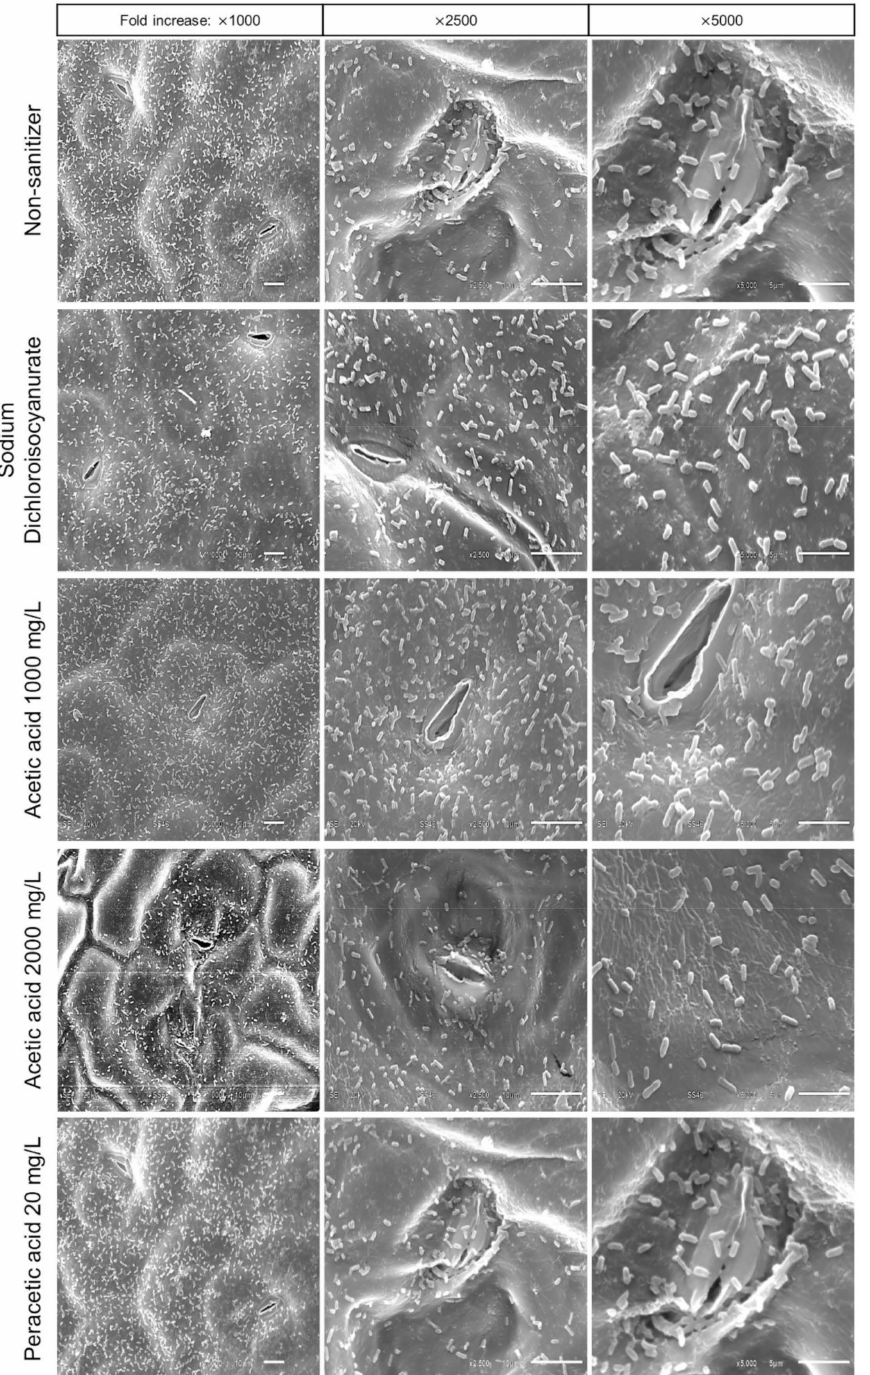
Figure 3. Scanning electronic microscopy micrographs of kale samples intentionally contaminated with S. Typhimurium cells ATCC 14028 and submitted to different sanitization treatments (Non sanitizer, sodium dichloroisocyanurate; Acetic Acid 1000 mg/L; Acetic Acid 2000 mg/L, Peracetic Acid 20 mg/L) for 5